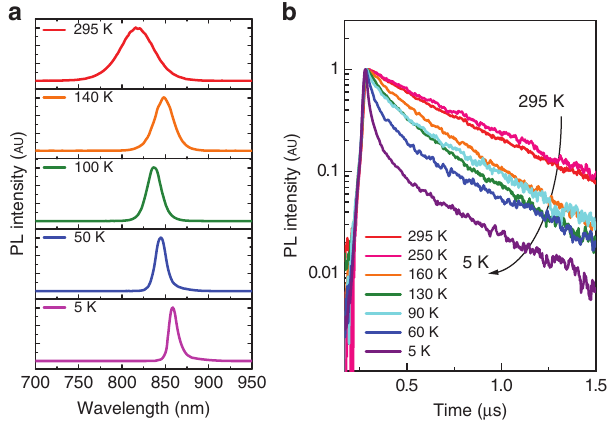
Figure 4 ( a ) PL spectra and ( b ) TRPL decay kinetics after photo- excitation with an excitation power density of 1.4 μ J cm − 2 at representative